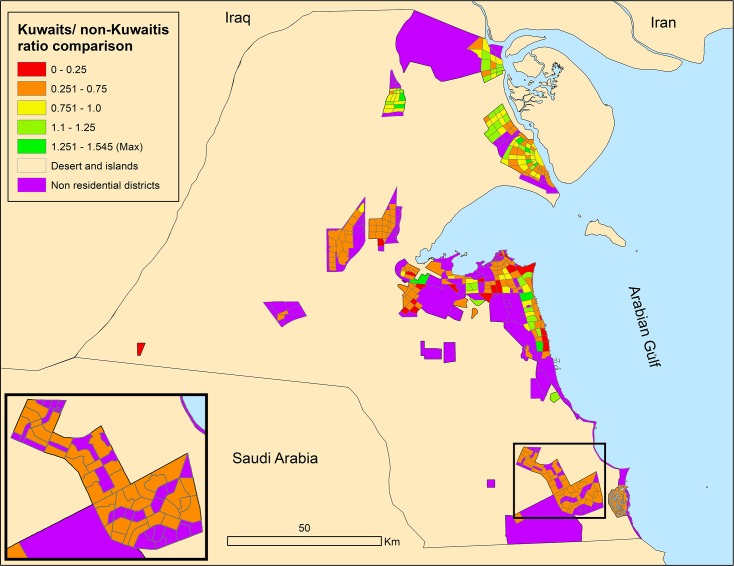
1st scenario segregation outcome map.